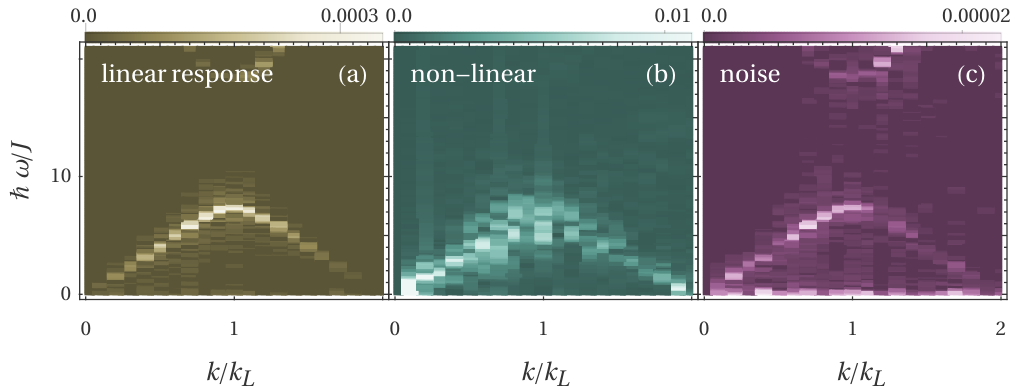
Figure 3: Square root of the power spectrum | δ ˜ ρ ( k , ω ) | of the density fluctuations obtained with three different tVMC simulation variants. Panel (a) shows the response to a weak multi-mode pulse of the form given in Eq. (8). In panel (b), the system is excited with a single mode at k = 0.1 k with an amplitude as large as the lattice L = V potential ( V ). In panel (c), no perturbation is applied and the density fluc- e 0 tuations in the time propagation are solely due to the stochastic noise in the Monte = 3 E Carlo simulation. In all three simulations the lattice amplitude is V and the r 0 BHM parameter is U / J =